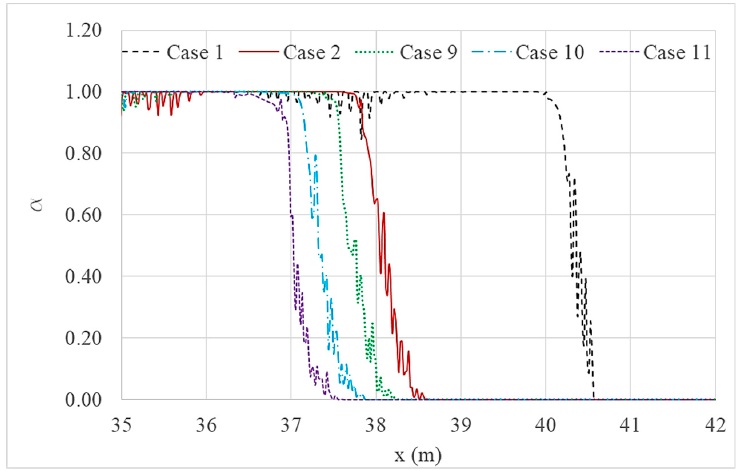
Figure 19. Comparison of wave run-up heights for each simulation case with different wall widths.